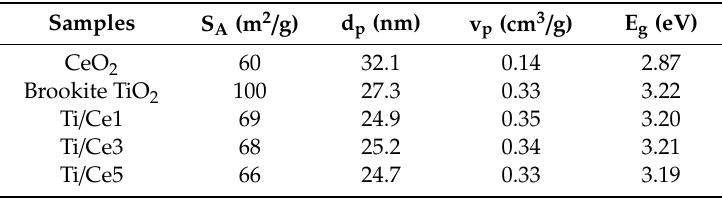
Table 1. Brunauer-Emmett-Teller specific surface area (S A ), mean pore diameter (d p ), pore volume (v p ) and optical band-gap (E g ) of the analyzed